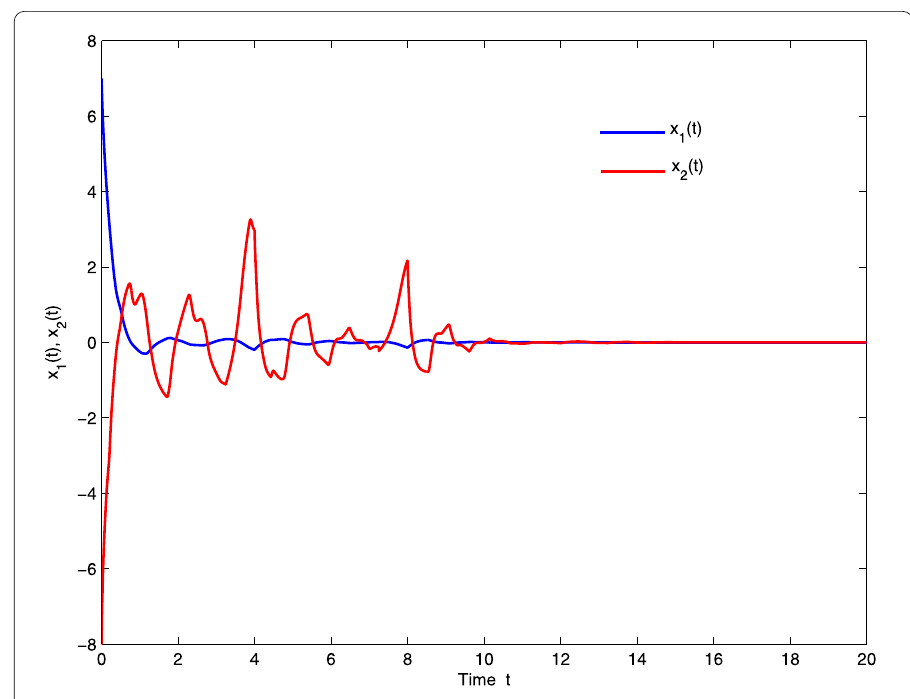
Figure 2 The trajectories of x 1 ( t ) and x 2 ( t ) of nonlinear system (35) with mixed time-varying delay and intermittent hybrid feedback control (36)